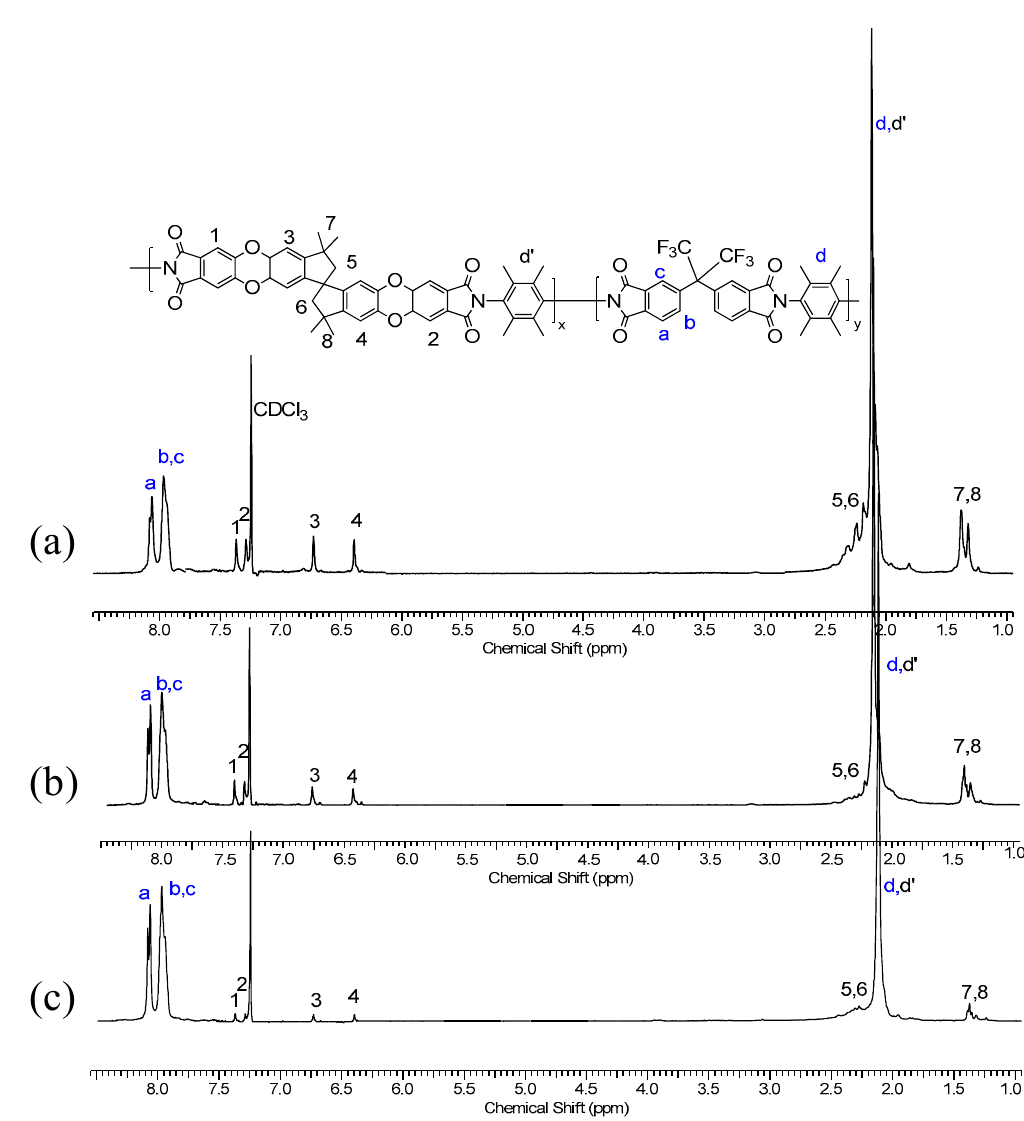
Figure 1. 1 H NMR spectra of the [(PIM-PI) x -(6FDA-durene-PI) y ] copolymers with different PIM-PI compositions, i.e., x:y = 1:4 ( a ), 1:6 ( b ) and 1:10 ( c ).